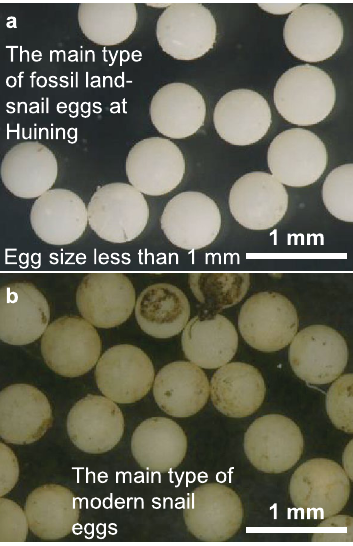
Figure 2. Fossil land-snail eggs from the Huining loess–paleosol sequence during MIS 12–10 and comparison with the same type of modern snail eggs from the Chinese Loess Plateau and East China. ( a ) Snail eggs from the Huining section. ( b ) The same type of modern snail eggs from surface soils of the Chinese Loess Plateau and East China.